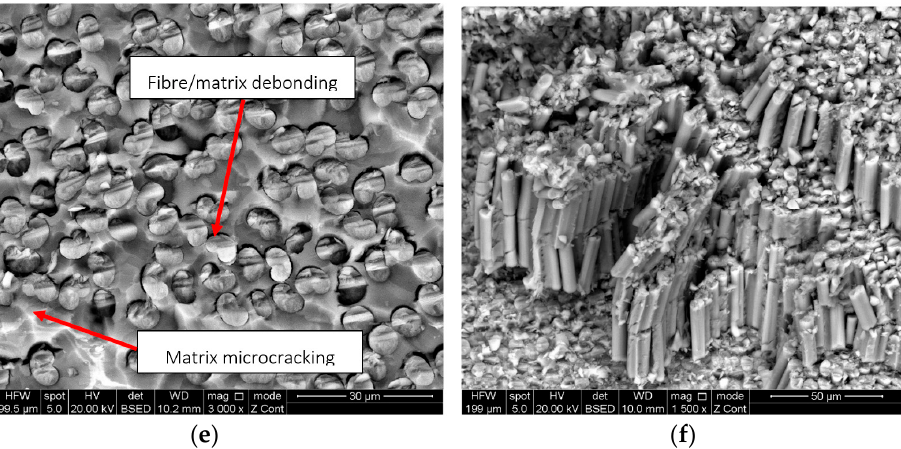
Figure 7. SEM images of a CPCT representative specimen: ( a ) general view, ( b ) structure collapse due to compressive load, ( c ) fibre pull-out, ( d ) delamination and fibre/matrix debonding, ( e ) fibre/matrix debonding and matrix microcracking, ( f ) fibre failure.